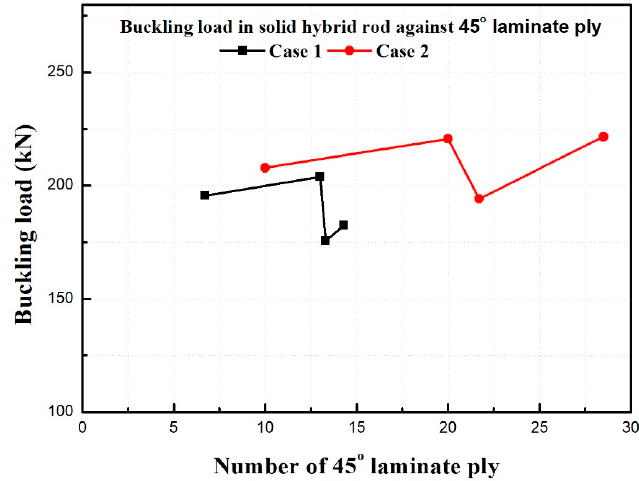
Figure 13. Variation of buckling load against 45 ◦ ply laminate in CFRP.